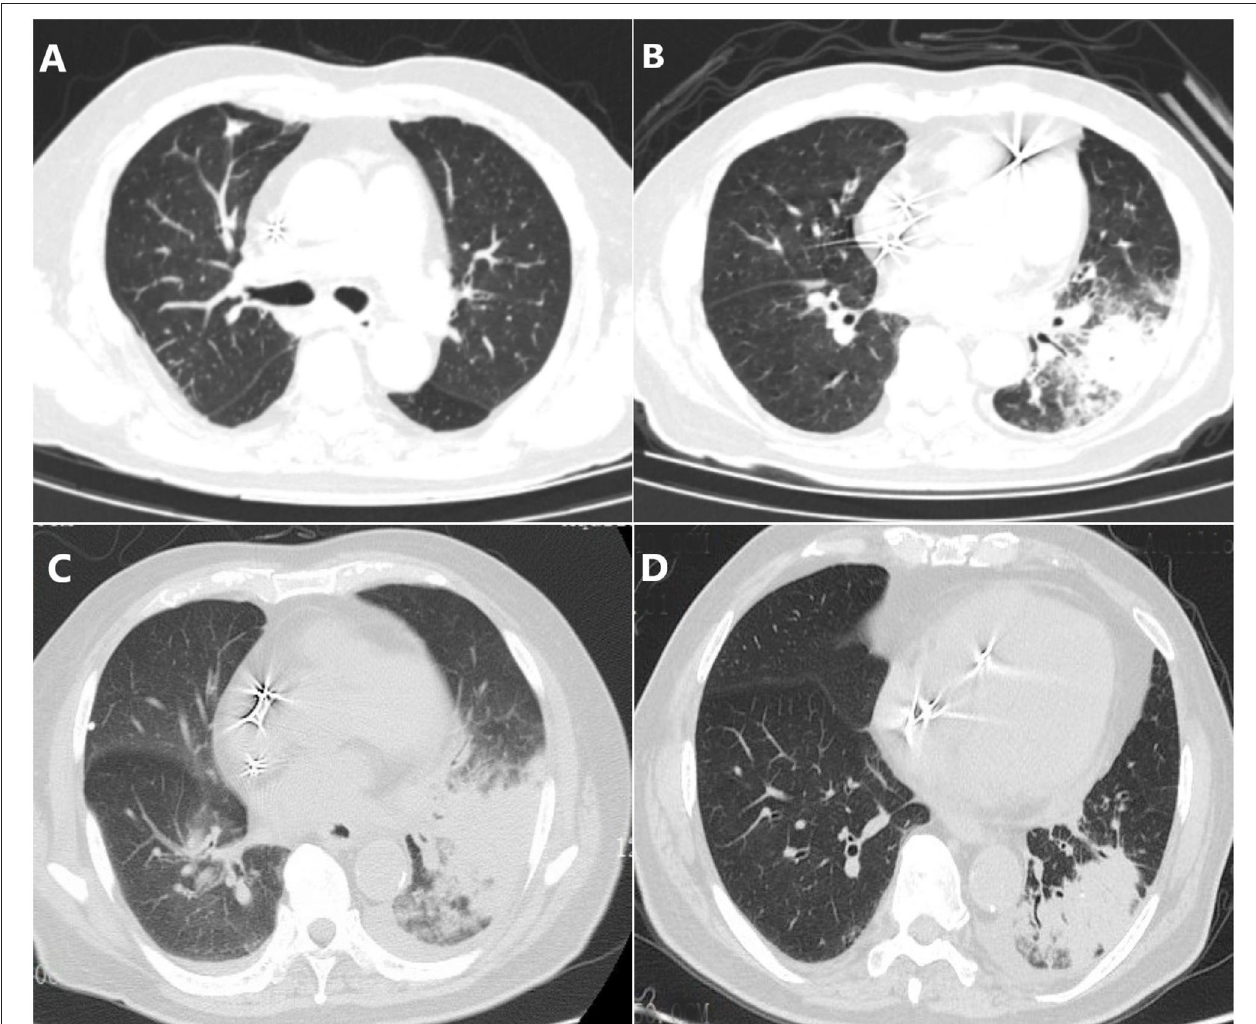
FIGURE 1 | Chest CT scans in different phases. (A) Ground-glass nodules in the upper lobe of the right lung with multiple enlarged lymph nodes in the mediastinum which were suspected of tumors. (B) Infectious lesions in both lungs, left hilar shadow increased, and mediastinal lymph nodes slightly enlarged. (C) The area of pneumonia was larger than before and pleural fluid appeared. (D) Pneumonia and pleural effusion were both absorbed